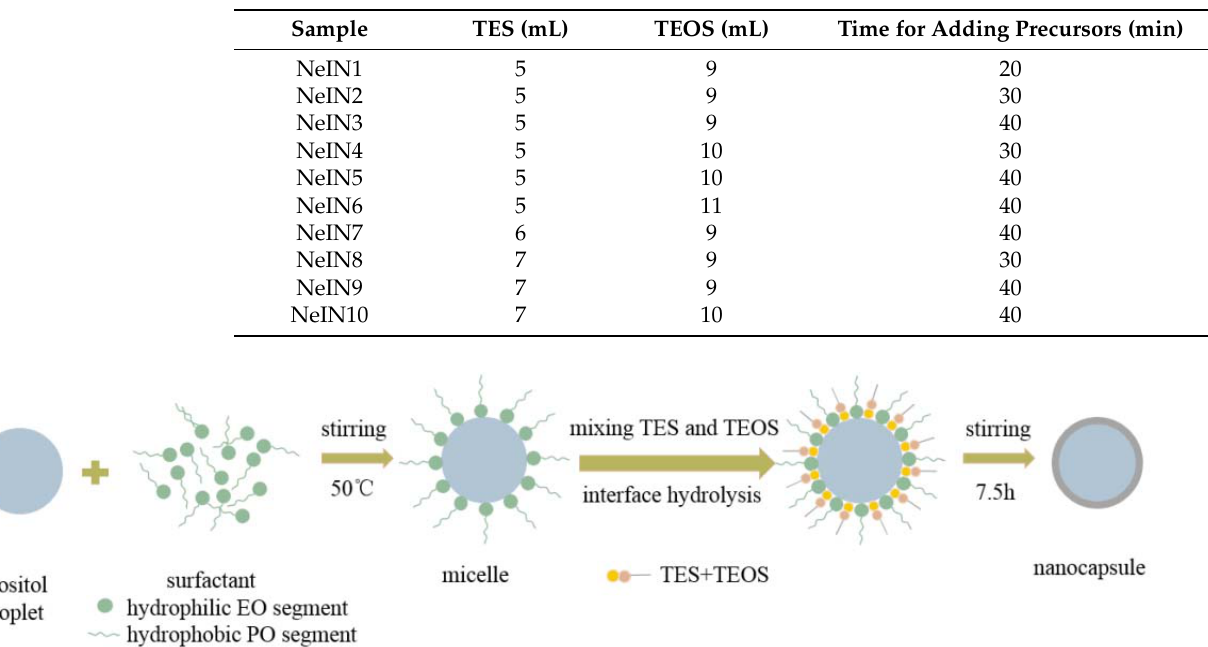
Table 1. Synthesis parameters for the preparation of the nanocapsules.